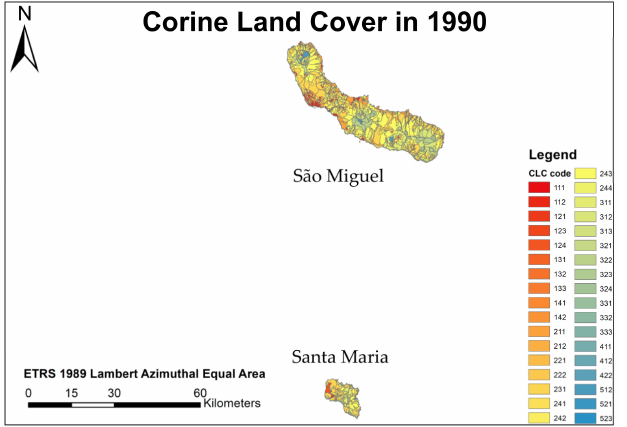
Figure A5. Thematic cartography regarding the land-use changes in the Eastern Group of Azores Archipelago in the year 1990.